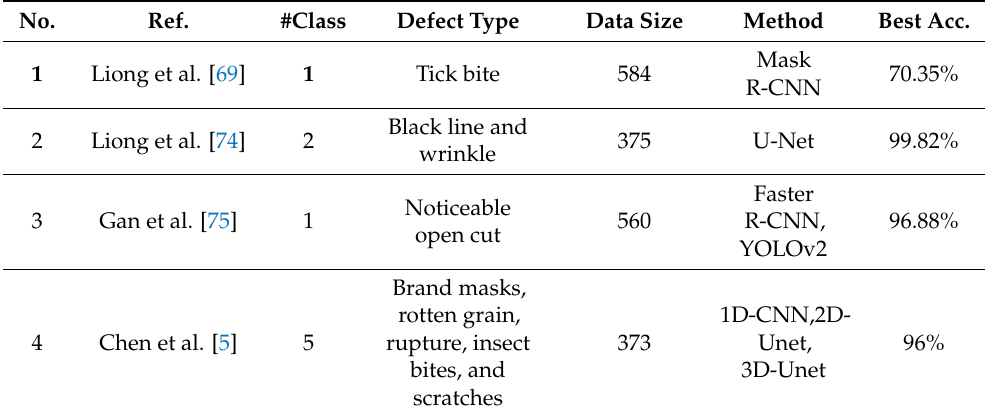
Table 8. Deep learning for leather defect